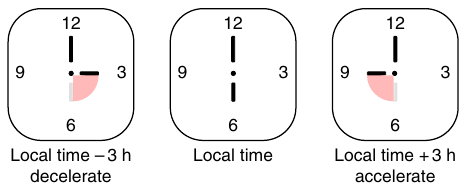
Fig. 3 Entrainment might involve transient changes in the velocity of an oscillator. We can conceptualise the problem of entrainment as setting the hands of a travel clock when moving between time zones. In the cartoon, we can see that if we move the time zones and readjust the hands of the clock to a new time zone, there is a temporary speeding up or slowing down of the movement of the hands to adjust to the new time zone, before the clock returns to its fi xed